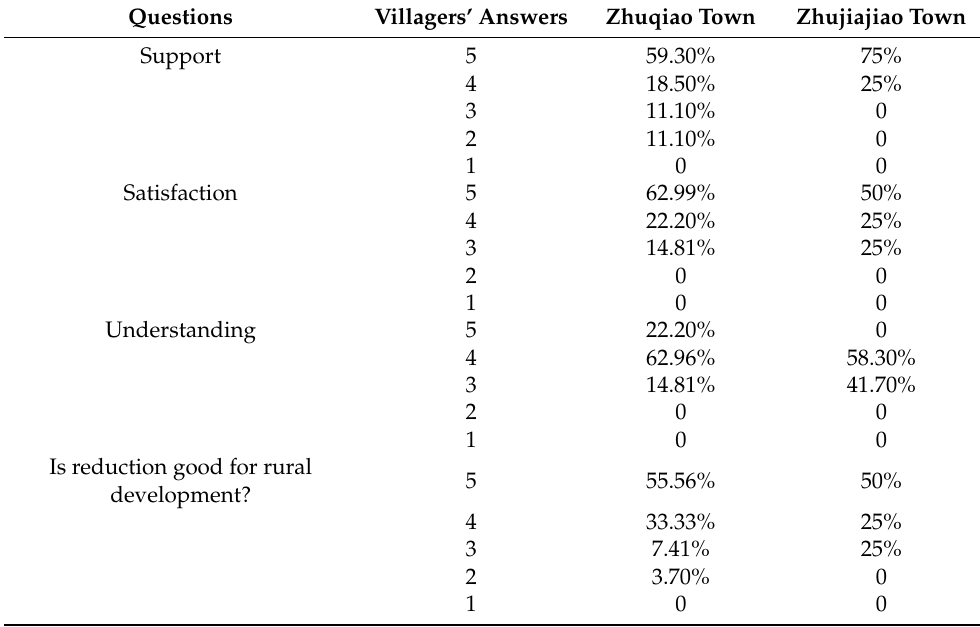
Table 1. Villagers’ perceptions of the